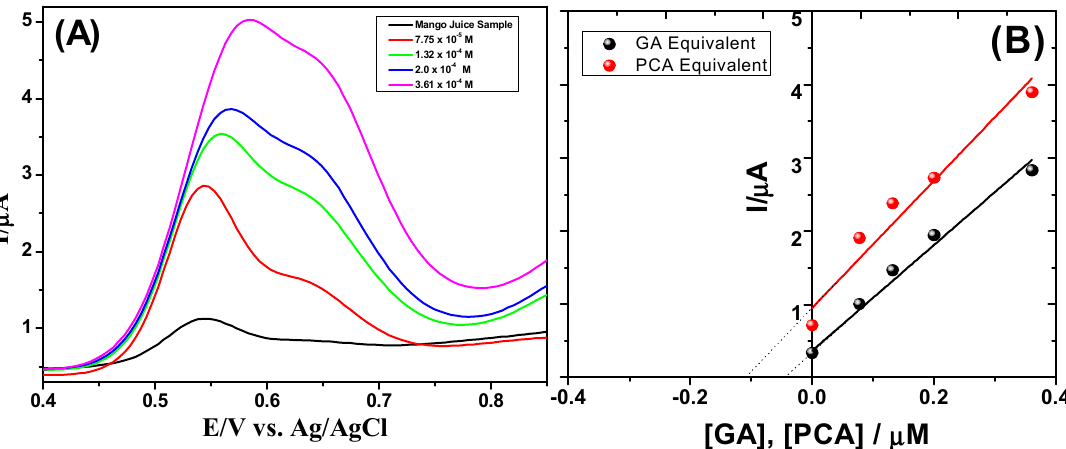
Figure 6. ( A ) Square wave voltammograms of a mango sample in B–R solution in optimal conditions: pH 2.1 at frequency 25 Hz and successive additions of standards GA and PA; ( B ) Standard addition plots of GA and PA in a mango sample.